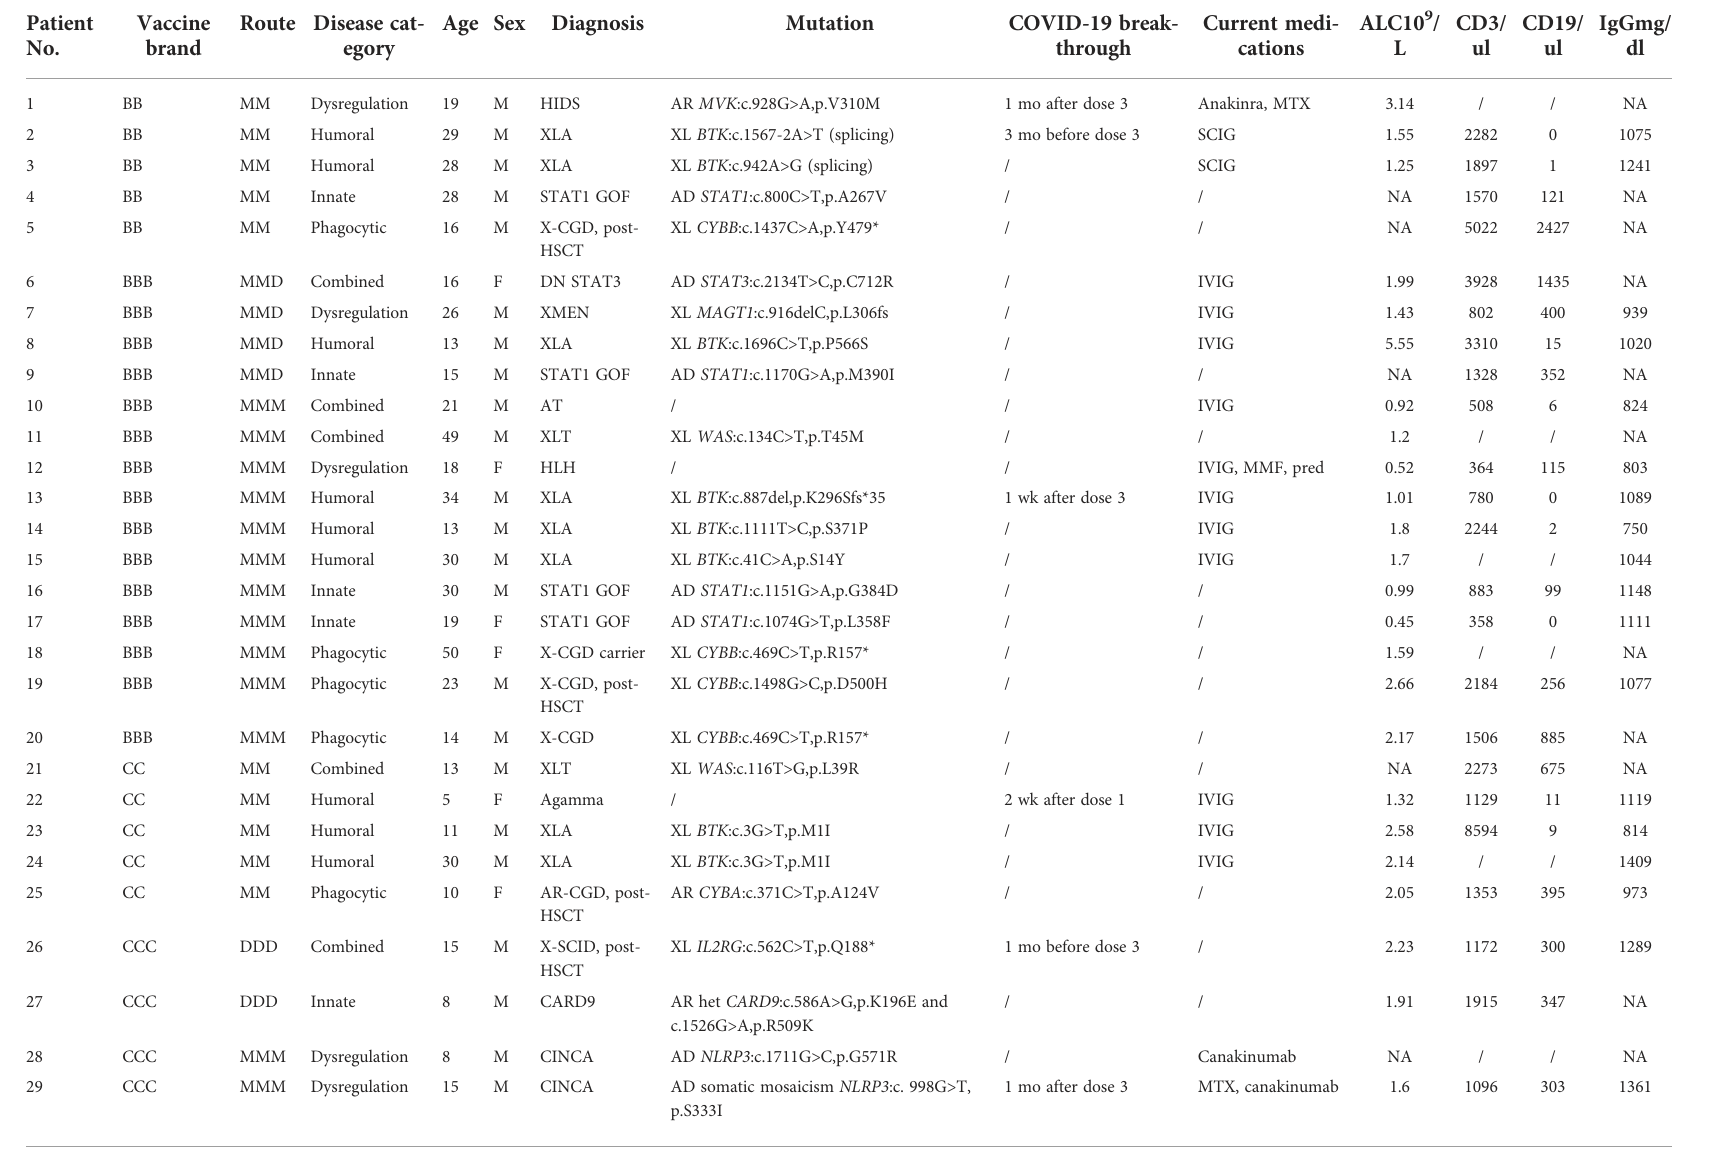
TABLE 1 Participant pro fi le. Patient